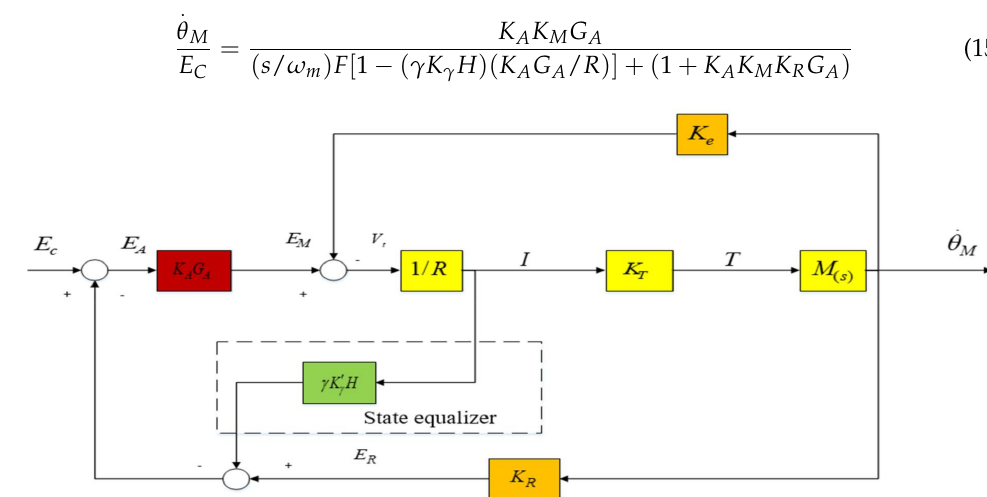
Figure 11. Resonant equilibrium velocity closed-loop